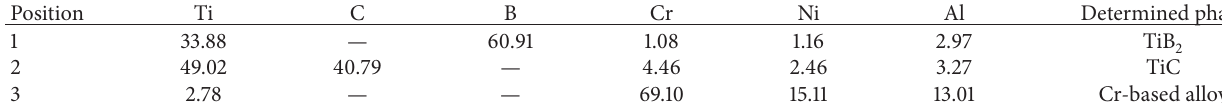
Table 1: Composition of the ceramic composites in the corresponding region of Figure 2 (atomic, %).